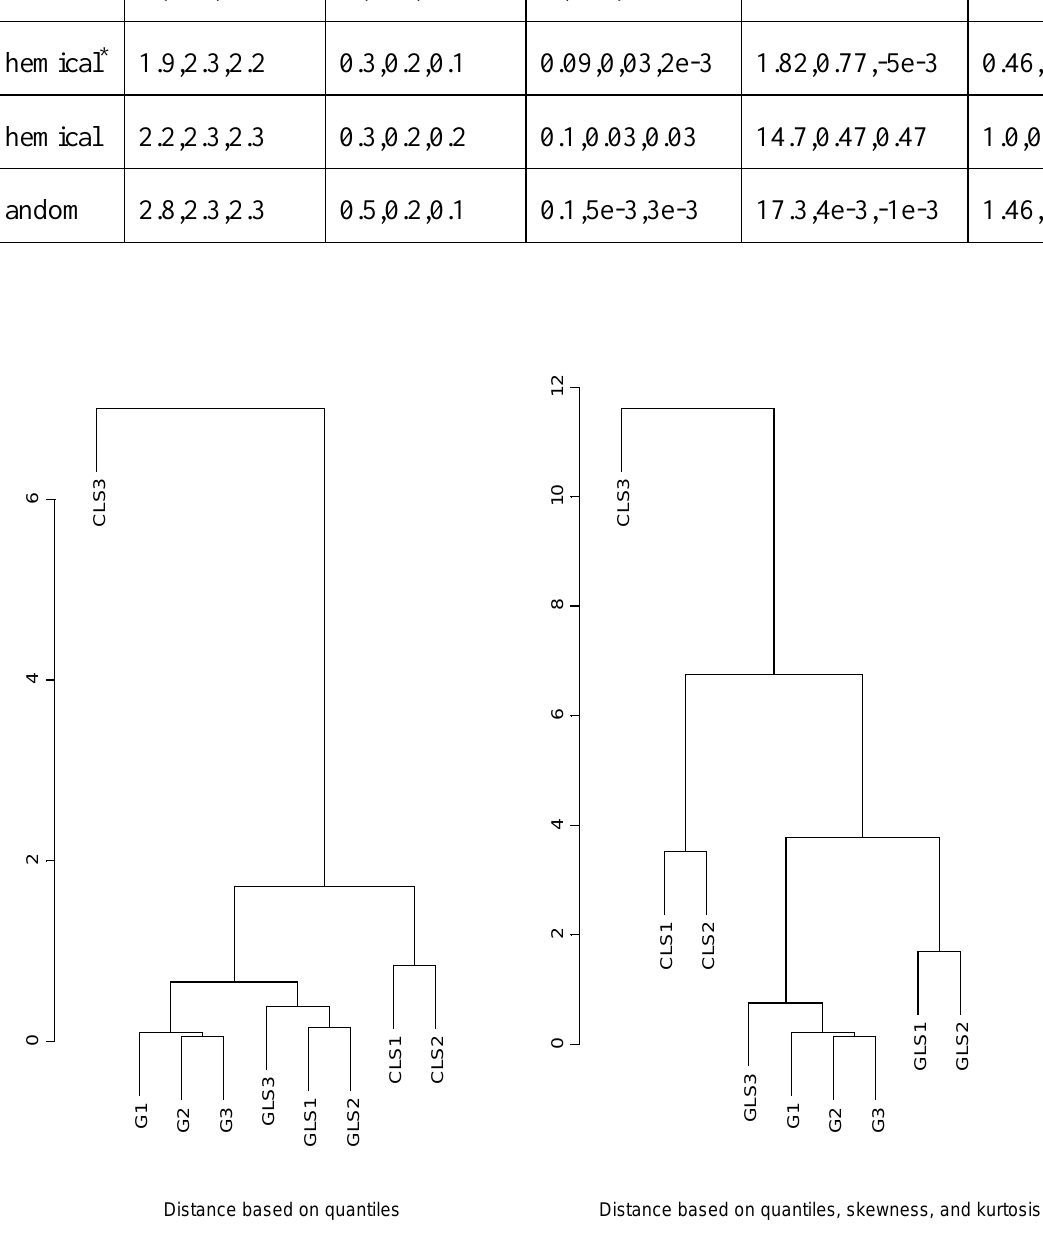
Figure 5 . Hierarchical clustering result showing that the GLS values are closer to Gaussian (G) than are the CLS values. The subcases are denoted 1, 2, and 3. Subcase 1 is in chemical directions chosen from the library of 296 chemicals to be mutually distinct. Subcase 2 is randomly chosen chemical directions from the library of 296 chemicals. Subcase 3 is in random directions. The plot depicts